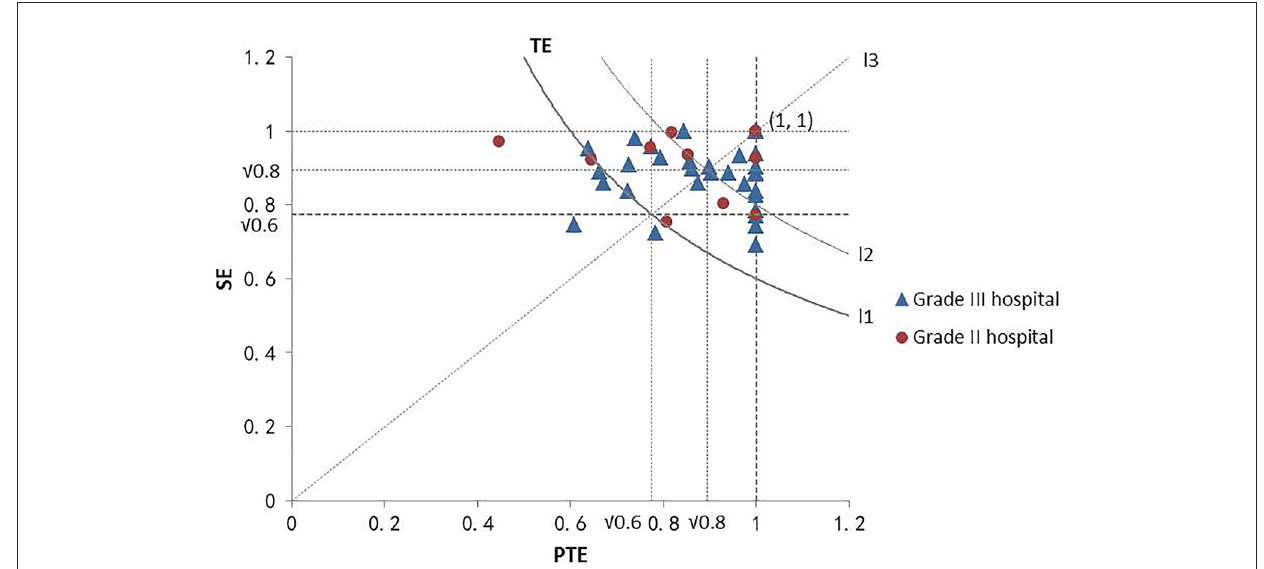
FIGURE3 DEA efficiency distribution of hospitals at different grades. The point at the bottom left of curve L 1 represents the comprehensive TE of the hospital at < 0.6. The point on curve L 1 represents the comprehensive TE of the hospital as 0.6. The point between curves L 1 and L 2 represents the comprehensive TE of the hospital between 0.6 and 0.8, and the point on the upper right of curve L 2 represents the comprehensive TE of the hospital > 0.8. The point above line L 3 represents SE greater than PTE. The point on line L 3 represents the SE was equal to PTE, and the point below line L 3 represents SE lower than